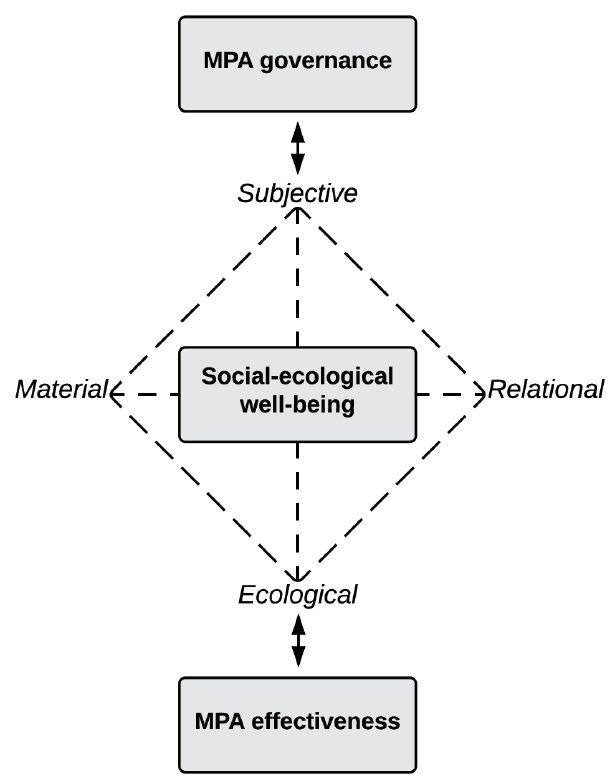
Fig. 1 . Framework for social-ecological